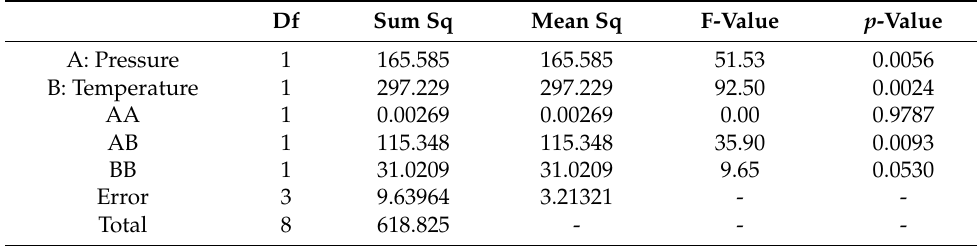
. ( a ) ( b ) Figure 5. Standardized Pareto chart of the ( a ) total ketoprofen loadings in PLA filaments and ( b ) percentage of superficial ketoprofen with respect to the total amount impregnated.